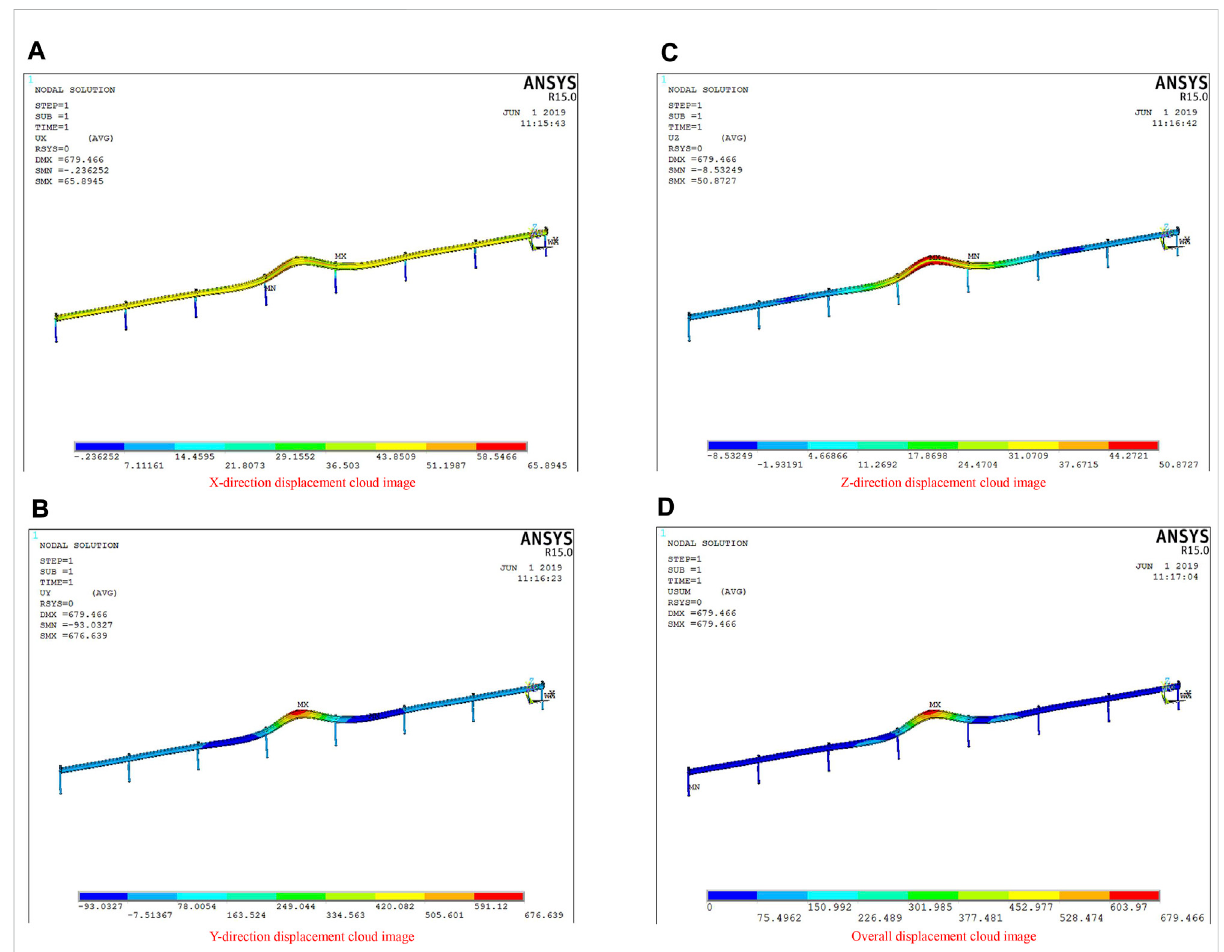
FIGURE 11 Displacementclouddiagramofathree-wavebeamsteelguardrail(impactedbythe40-tHGVatthespeedof65 km/hfromanangleof20 ° ,the soil-embeddedguardrailpost). (A) :X-directiondisplacementclouddiagramofthree-wavebeamsteelguardrail. (B) :Displacementclouddiagramof three-wave beam steel guardrail in Y direction. (C) : Displacement cloud diagram of three-wave beam steel guardrail in Z direction. (D) : The overall displacement cloud diagram of the three-wave beam steel